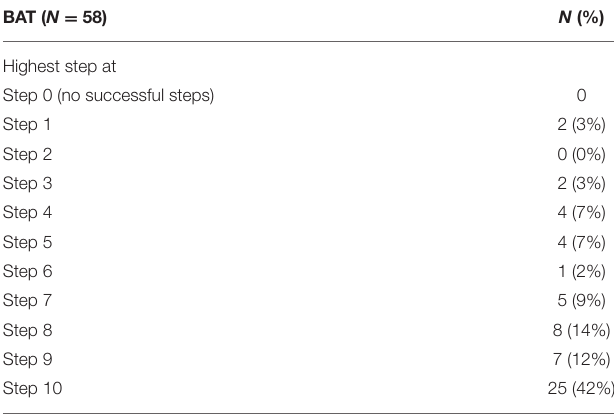
TABLE 1 | Demographical and clinical characteristics of the sample. TABLE 2 | BAT-score at start of